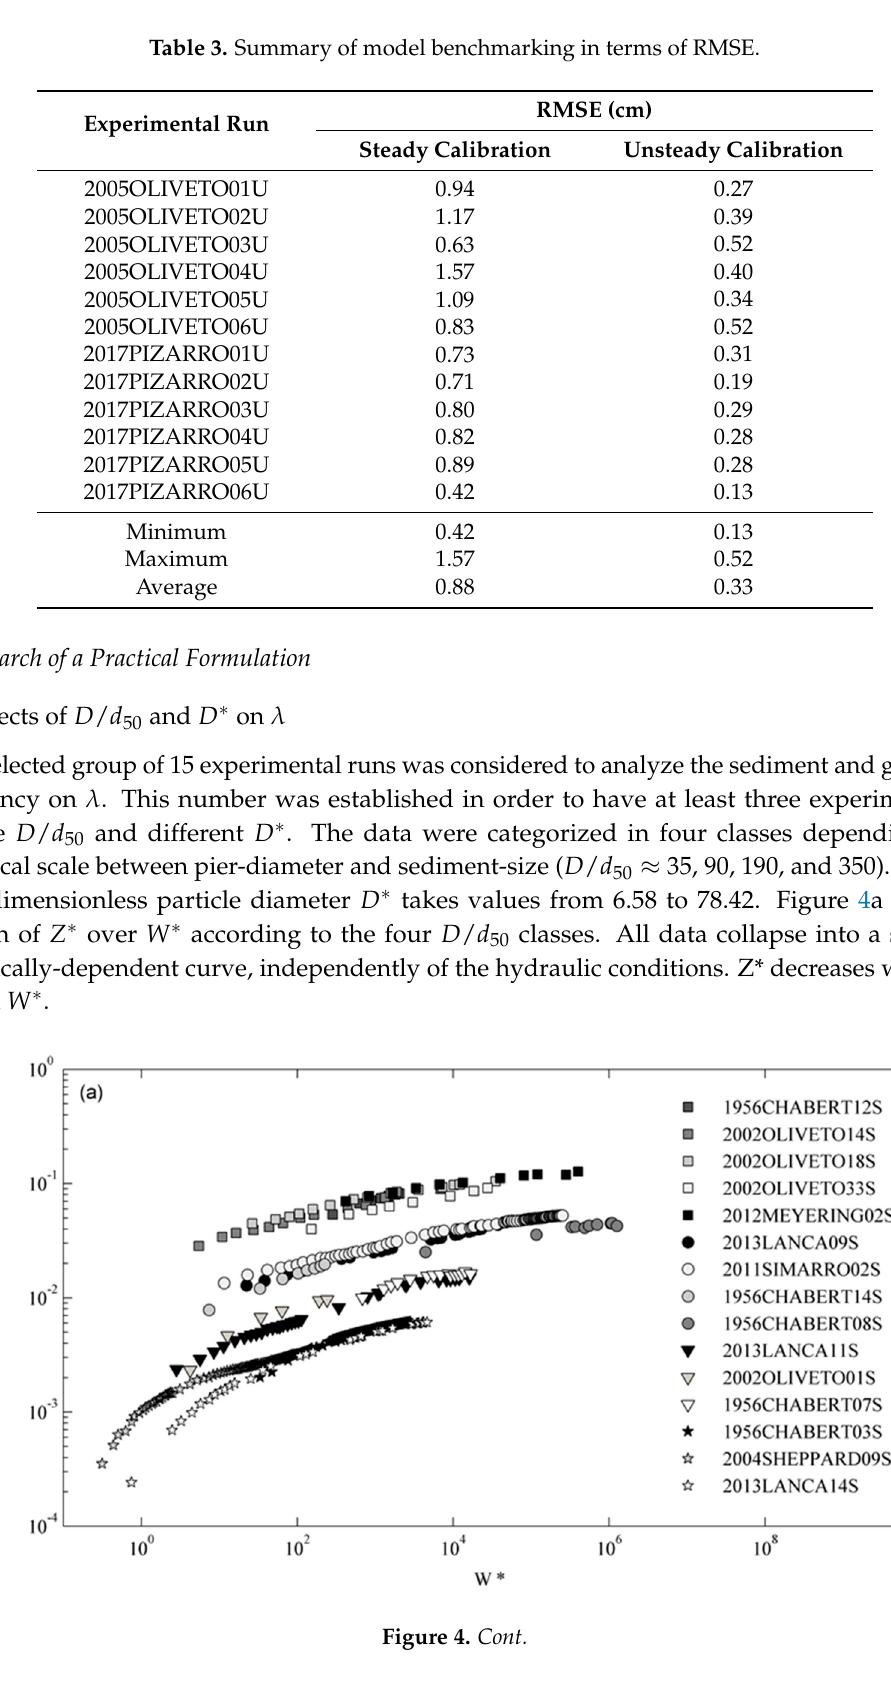
Figure 4. ( a ) Relative scour evolution over W * for the four categorized classes; ( b ) λ calibrated values in function of the dimensionless particle diameter D*. The fitting coefficient (cid:2019) is always affected by the ratio between pier-diameter and sediment size, even for high values. Thus, a stabilizer or equilibrium threshold for it was not found.